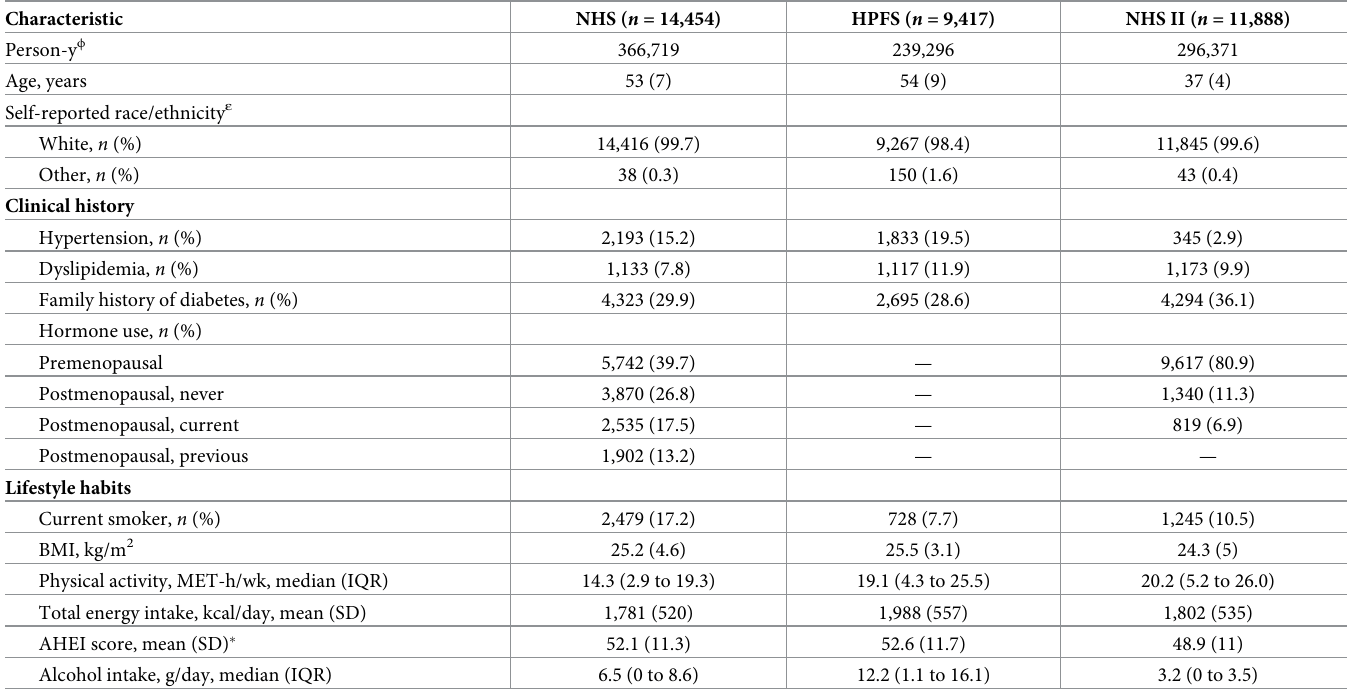
Table 1. Baseline characteristics of the 35,759 US men and women in the NHS I, the HPFS, and the NHS